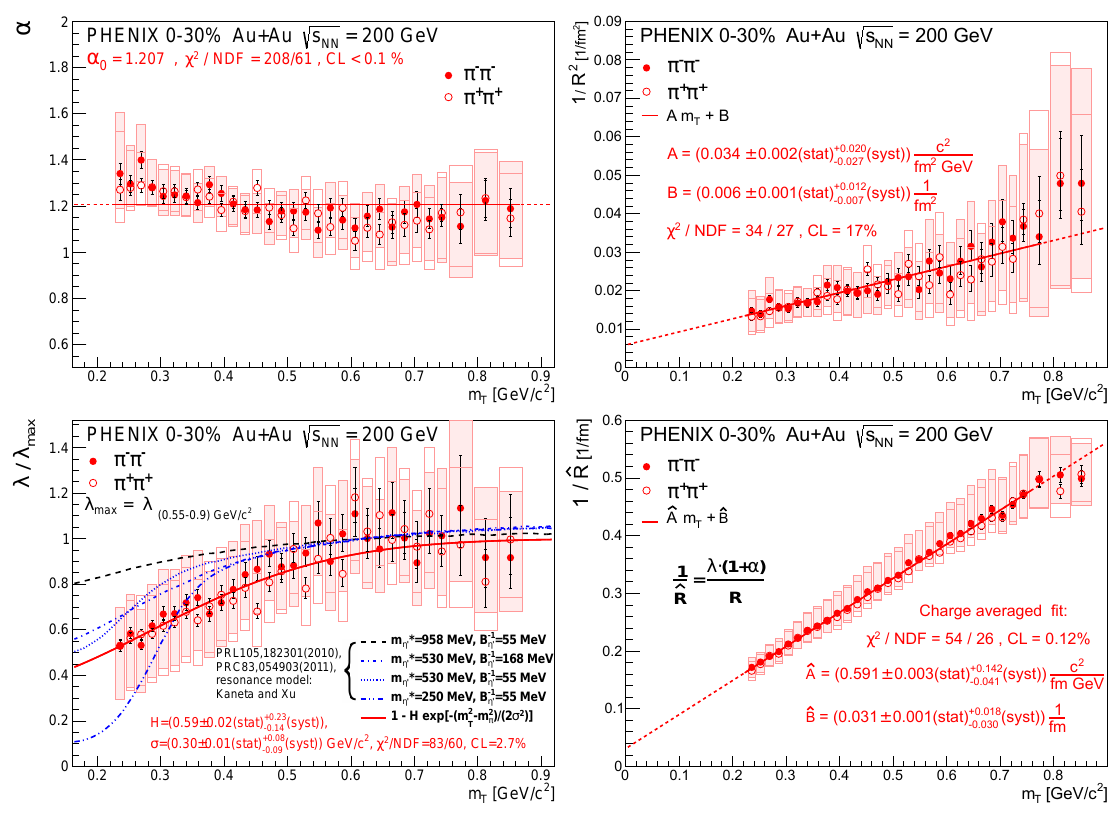
Figure 2. Fit parameters α ( top left ), R ( top right , shown as 1/ R 2 ), λ ( bottom left , shown as λ / λ max ) and (cid:98) R ( bottom right , shown as 1/ (cid:98) R ) versus average m T of the pair. Statistical and symmetric systematic uncertainties shown as bars and boxes,